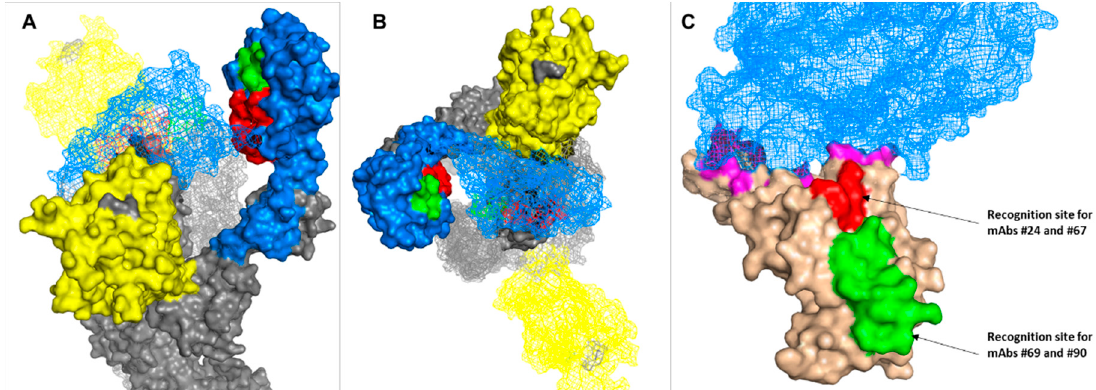
Figure 7. Modeling of the epitopes targeted by anti-RBD antibodies. Side ( A ) and top ( B ) view of epitope 404 GDEVRQI 410 (green: recognition site for antibodies #69 and #90) and epitope 376 TFKCYGVSPTKLNDL 390 (red: recognition site for antibodies #24 and #67) localization on two out of the three subunits composing the crystal structure of SARS-CoV-2 spike (PDB 7C2l). The subunit whose RBD (light blue) is in the “up” configuration is presented in surface mode, whereas the other subunit whose RBD is in the “down” formation is shown as a mesh. The NTD is colored in yellow. ( C ) Crystal structure (PDB 6lzg) of RBD (light brown) bound to ACE2 (light blue mesh). RBD residues that are in direct contact with the receptor are colored in magenta. Neutralizing antibodies’ epitopes are colored in green and